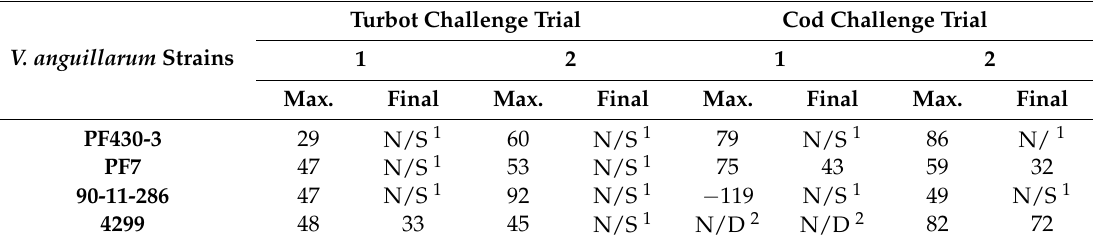
Table 1. Overview of the percent reduction in mortality caused by phage KVP40 addition in the four experiments. The maximum relative reduction and reduction at the end of the experiment (final) is shown.